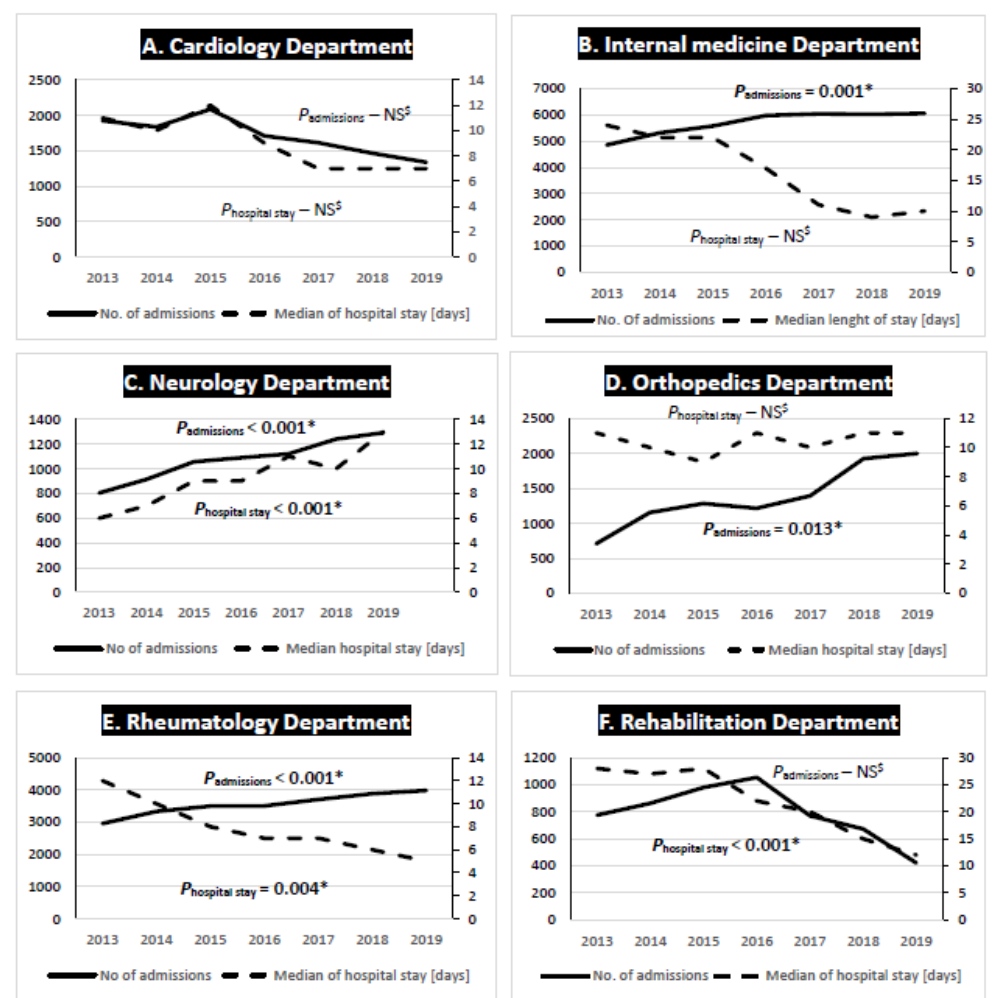
Figure 1. Trends of median hospital stay and annual number of admissions across the analyzed clinical departments. $ NS—non-significant; * significant p -value. The crude incidence rate (cIR) of falls was 6.484 per one thousand hospitalizations. In the 2013–2017 period, an increasing trend of total cIR was observed, reaching the peak value in 2016; it was followed by a slight decline from 2017 to 2019 (Figure 2).